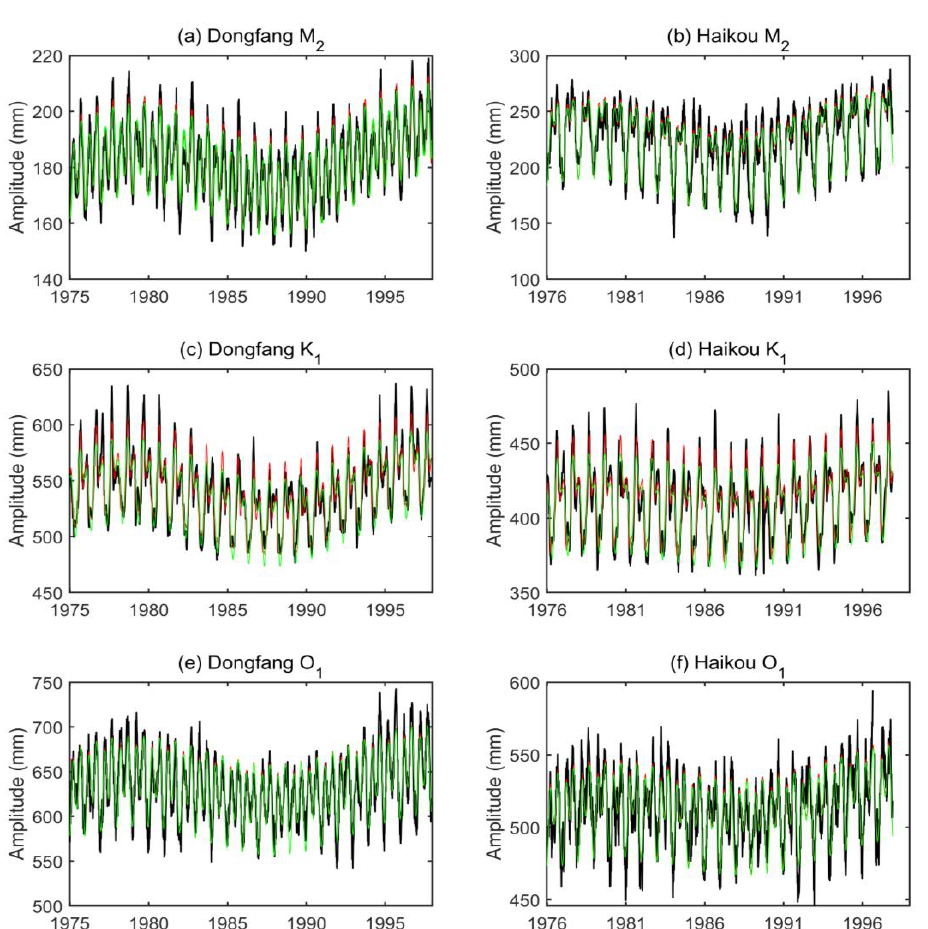
Figure A2. ( a ) The observed (black line) and fitted (red line) weekly M 2 amplitudes at Dongfang. ( b ) The observed (black line) and fitted (red line) weekly M 2 amplitudes at Haikou. ( c ) The observed (black line) and fitted (red line) weekly K 1 amplitudes at Dongfang. ( d ) The observed (black line) and fitted (red line) weekly K 1 amplitudes at Haikou. ( e ) The observed (black line) and fitted (red line) weekly O 1 amplitudes at Dongfang. ( f ) The observed (black line) and fitted (red line) weekly O 1 amplitudes at Haikou. Green lines represent the fitted results without subseasonal cycles.